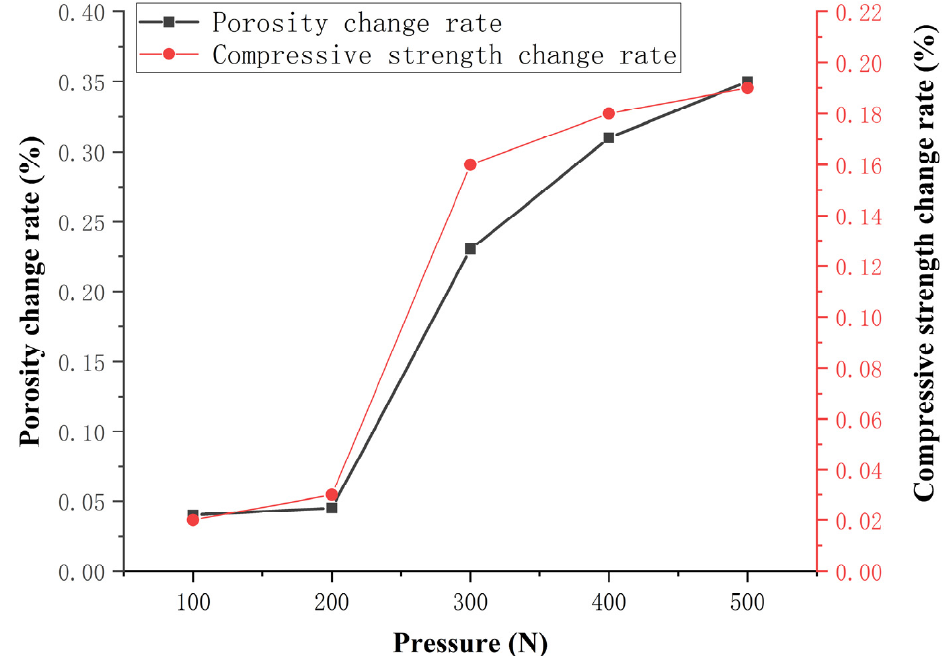
Figure 4. The relationship between static load pressure and rock porosity change rate and compres- sive strength change rate.